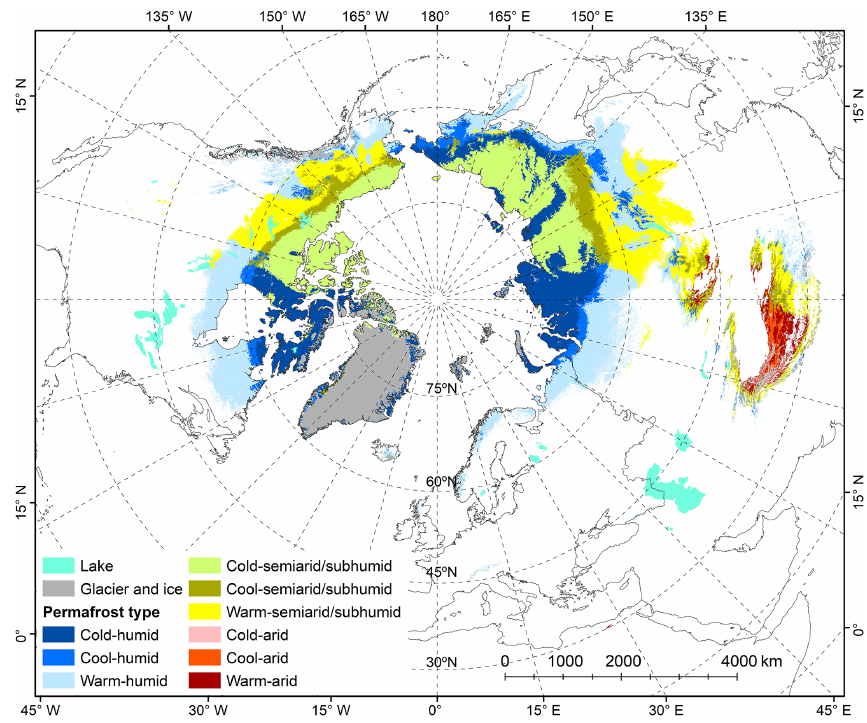
Figure 9. Hydrothermal-condition-based permafrost zonation in the Northern Hemisphere for the period of 2000–2016. Table 3. The zonal areas of different permafrost hydrothermal conditions (10 6 km 2 ) over the currently exposed land surface in the Northern